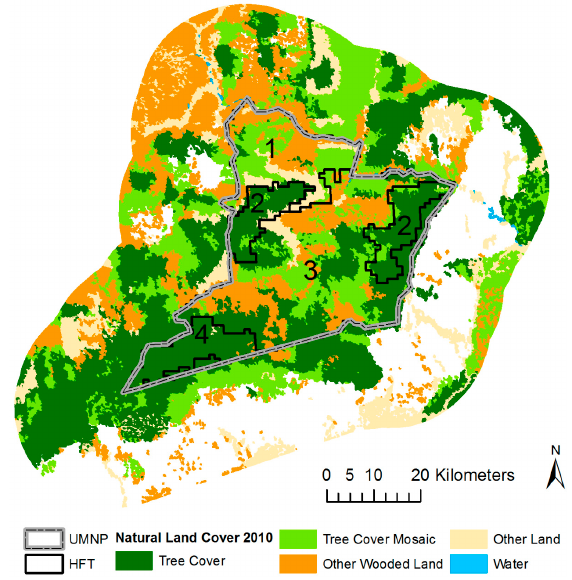
Figure 3. Map of Habitat Functional Type (HFT) clusters obtained in the PA overlaid with the LULC map representing natural vegetation only. The areas in white symbolize non natural vegetation (e.g., agriculture).